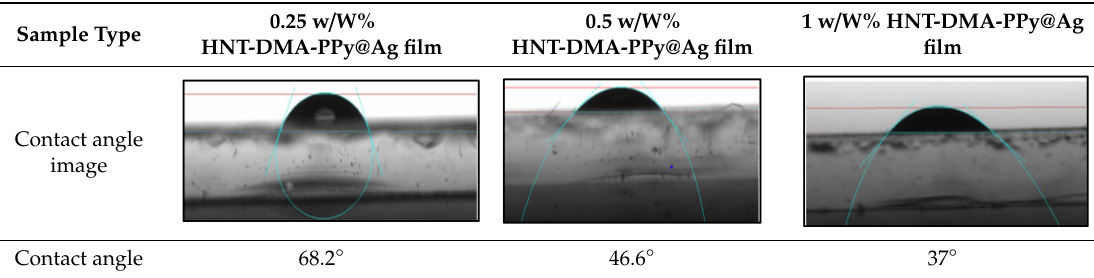
Table 3. Contact angle measurements of HNT-DMA-PPy@Ag film (0.25 wt%, 0.5 wt%, and 1